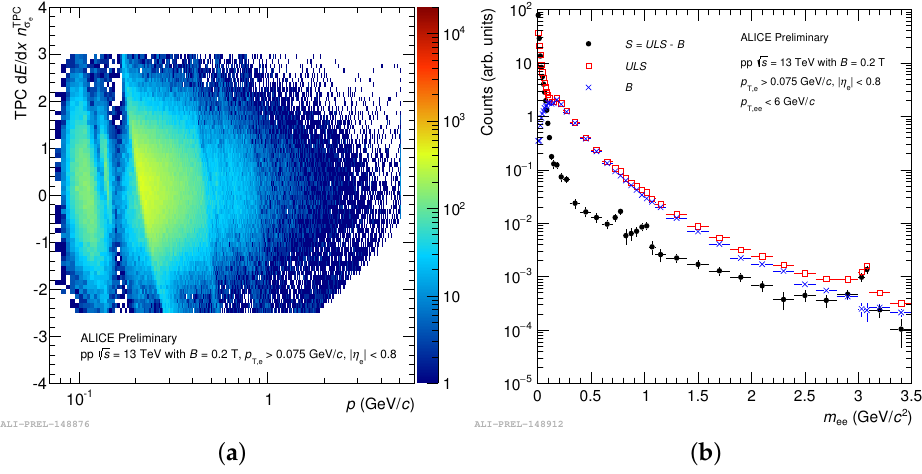
Figure 1. ( a ) Specific energy-loss of electron candidates in the TPC as a function of their momentum after applying all selection criteria. ( b ) Illustration of the like-sign subtraction method. The unlike-sign pairs are shown in red, the like-sign in blue and the resulting signal in